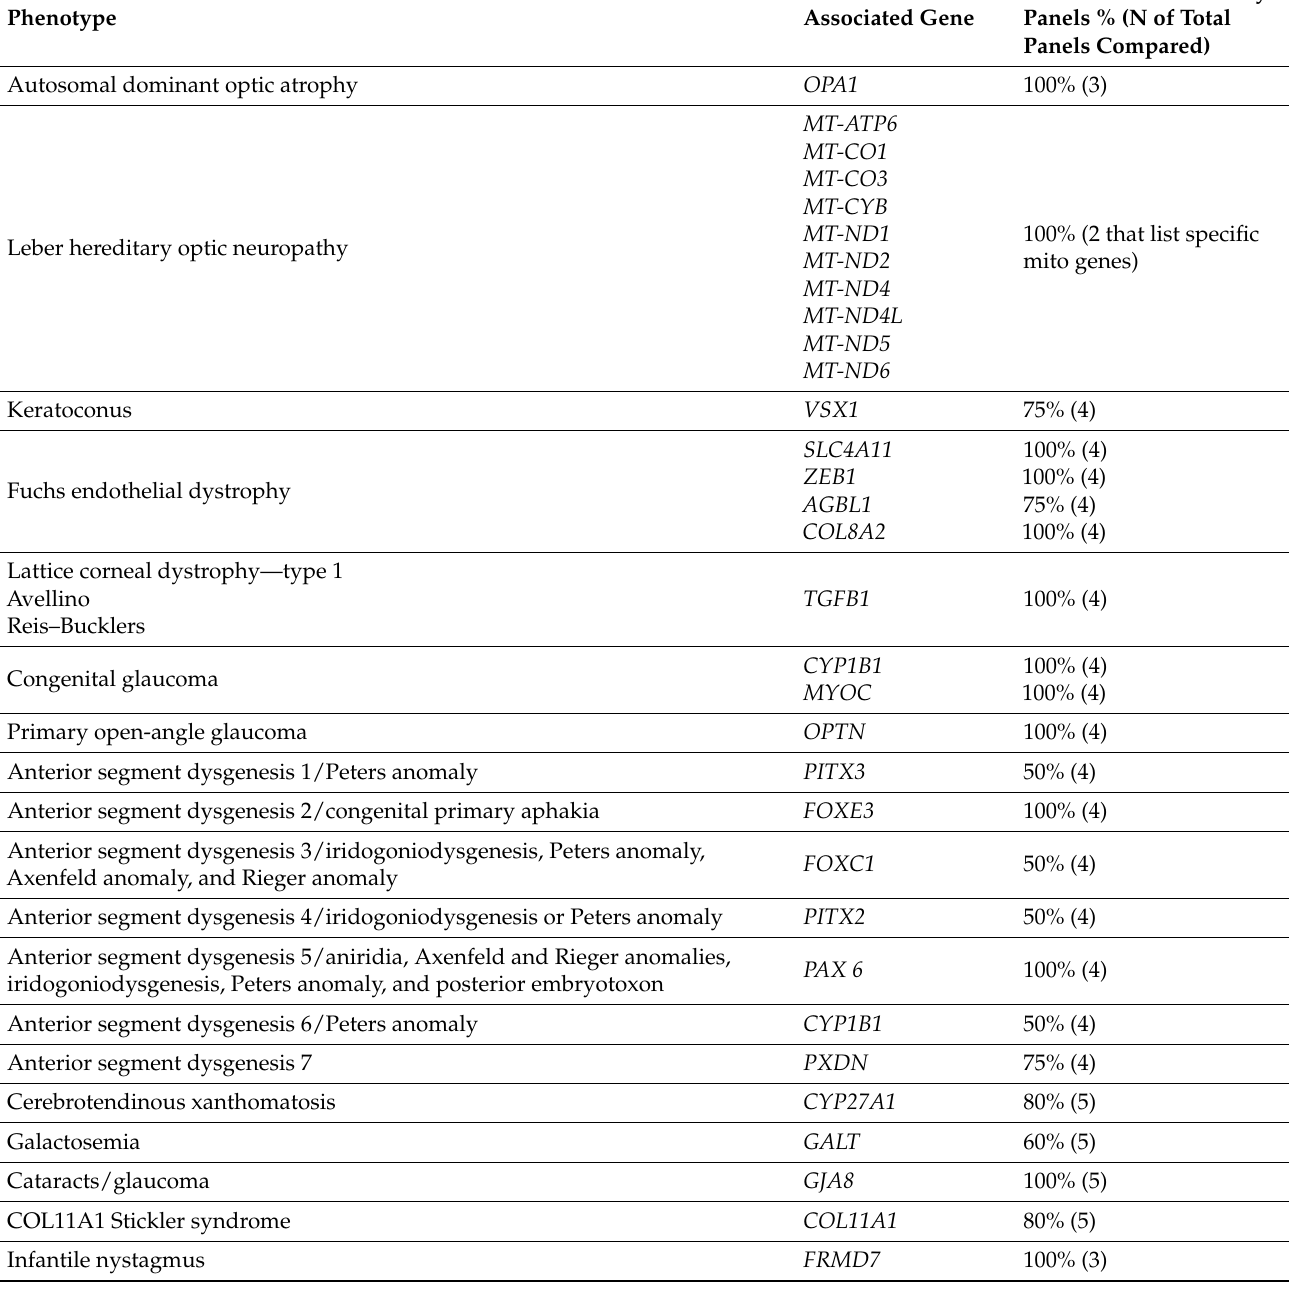
Table 1. Common Phenotype/Genotype associations and panel